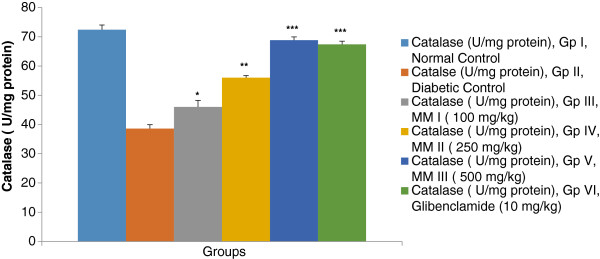
Effect of Melastoma malabathricum Linn. (MM) on Catalase (CAT) at different concentrations on STZ induced diabetic rats, compared to standard drug Glibenclamide; values are mean ± SEM; n = 6; *P < 0.05; **P < 0.01; ***P < 0.001; P > 0.05 is considered as non-significant (ns).